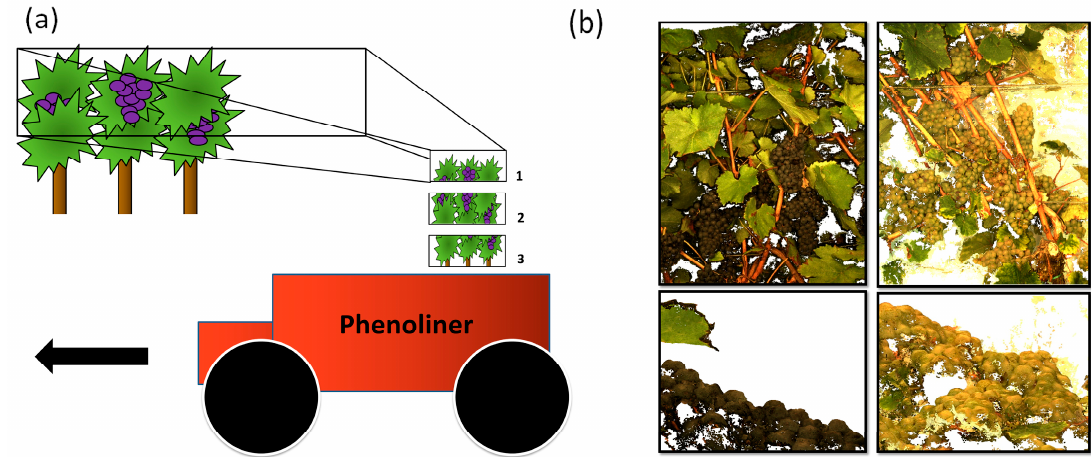
Figure 5. ( a ) Basic principle of the system setup for 3D reconstruction of the full vine row. The Phenoliners tunnel is driven over the vine rows. The MCS is oriented parallel to the rows, capturing images automatically while in motion. ( b ) Reconstructed point cloud of black (left side) and green grape (right side) varieties. The upper images show the rows from a frontal view and the lower images show grapes from a profile view. Single berry elevations of their spherical geometry are clearly distinguishable.